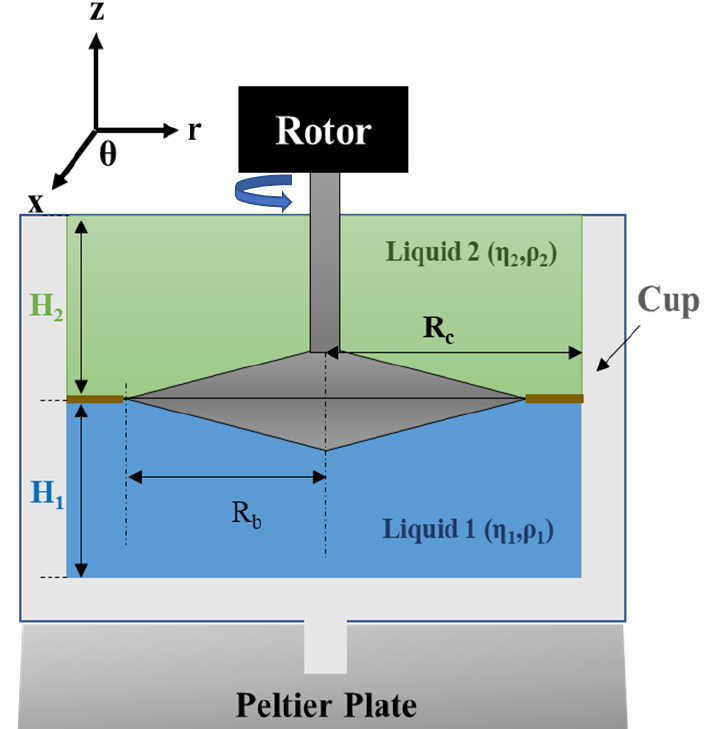
Figure 12. Schematic diagram of the rotating biconical bob rheometer [50]. Copyright 2022 AIP Publishing.